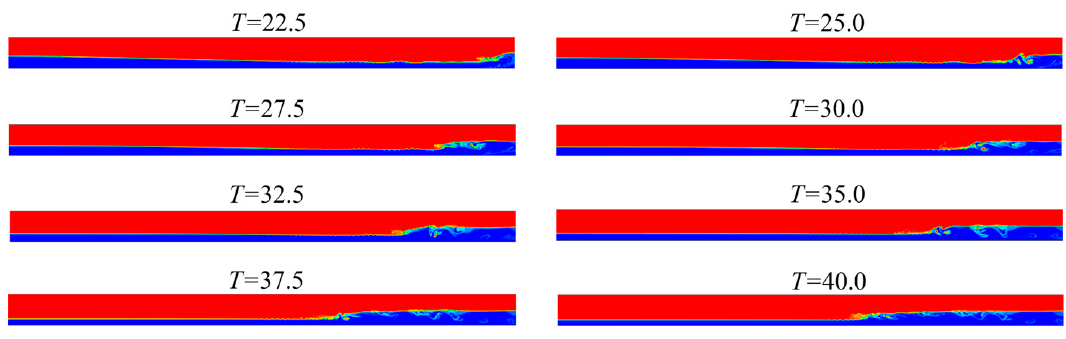
Figure 15. Free surface at T = 22.5–40.0.